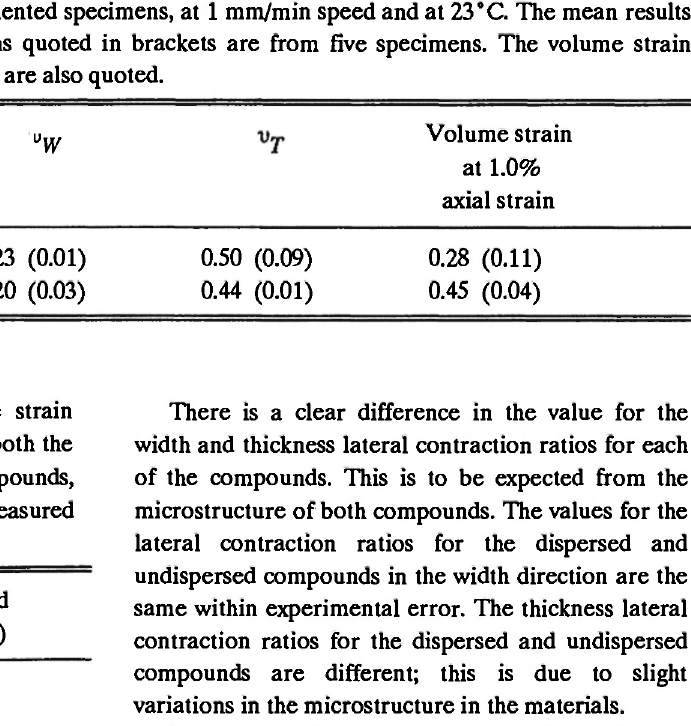
Table 7: Tensile modulus, width and thickness lateral contraction ratios (all measured at 0.2% applied strain) for both compounds, tested using 90° oriented specimens, at 1 mm/min speed and at 23 °C. The mean results together with the standard deviations quoted in brackets are from five specimens. The volume strain measurements at 1.0% applied strain are also quoted.